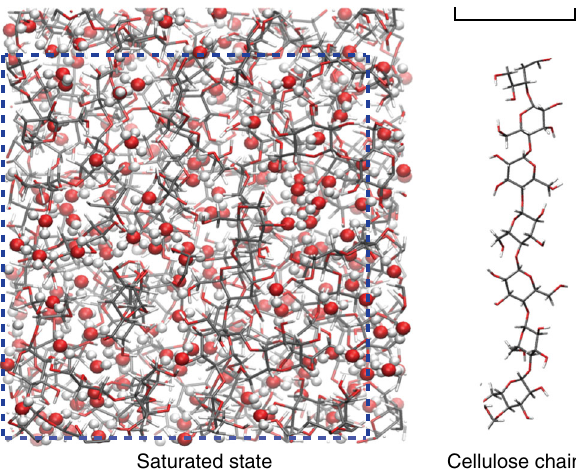
Fig. 1 Microscopic model of water sorption in cellulose. Molecular con fi guration of cellulose upon water adsorption at a relative humidity close to RH = 1 and a temperature T = 300 K. The sticks are the bonds between the C, O, and H atoms in cellulose while the red and white spheres are the O and H atoms of water. The box size is 3.10 × 3.31 nm. The blue dashed line shows the system size of the dry material before adsorption. A cellulose chain is shown on the right. The scale bar represents 1